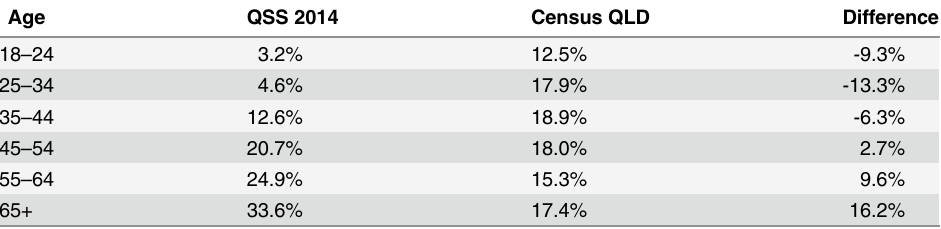
Table 1. Age distribution for the Queensland Social Survey 2014 compared with census data